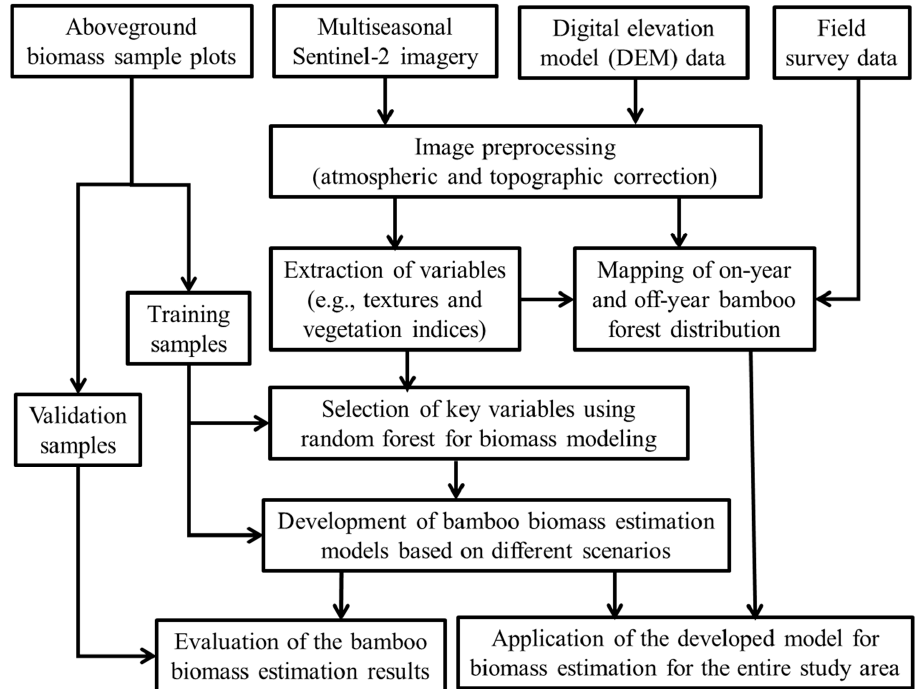
Figure 4. Framework of mapping bamboo forest aboveground biomass distribution using Sentinel-2 data.